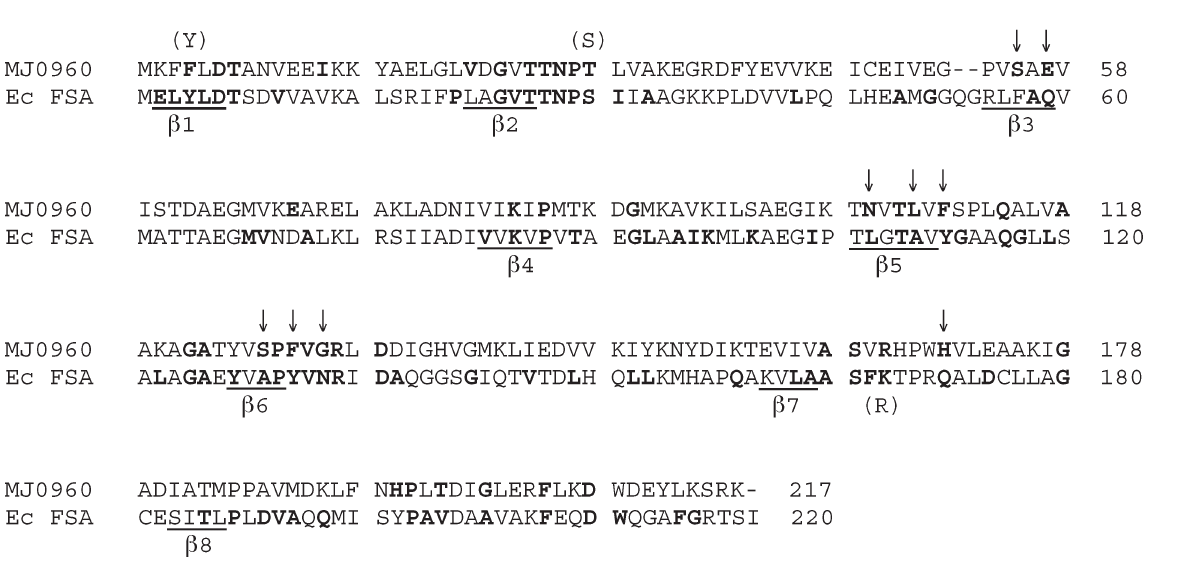
Figure 4. Alignment of M. jannaschii transaldolase (MJ0960) and E. coli FSA (Ec FSA) sequences. Conserved residues among 40 transaldolase and six FSA sequences are in bold, with conservative substitutions in parentheses above or below the sequence. The regions corresponding to the eight β sheets of the FSA α / β barrel structure (Thorell et al. 2002) are underlined. Arrows indicate conserved residues that are unique to the transaldolase sequences and that are in or near the probable active site of the enzyme.